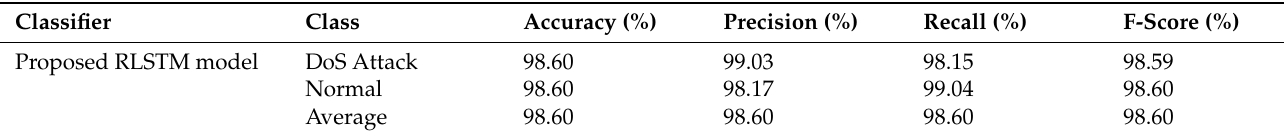
Table 4. Results of NSL-KDD. Table 5. Results of CICIDS-2017.